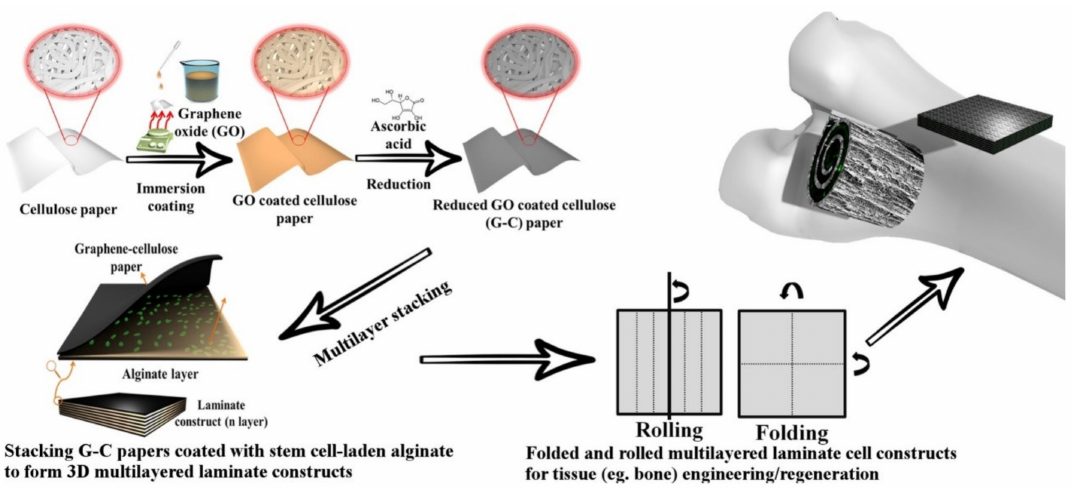
Figure 2. The fabrication stages of G-C paper and origami inspired cell-laden constructs ( left ); Rolling and folding of the 3D structures for applications in bone tissue regeneration ( right ) [58]. Reproduced with copyright